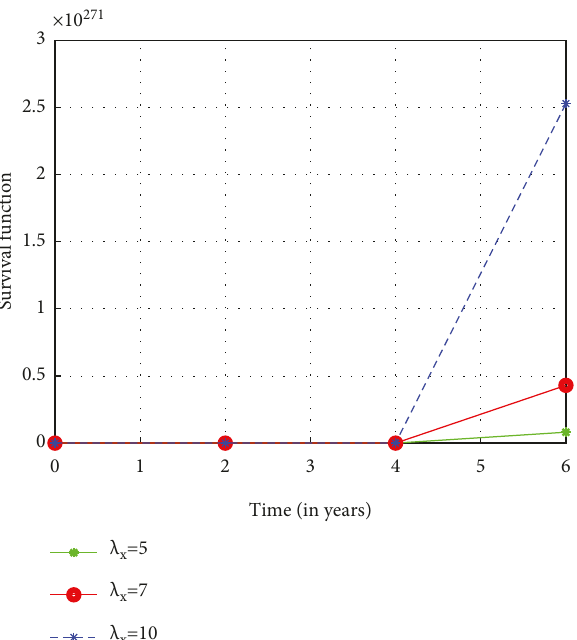
Figure 1: Dependence of the survival function on the intensity of the counting